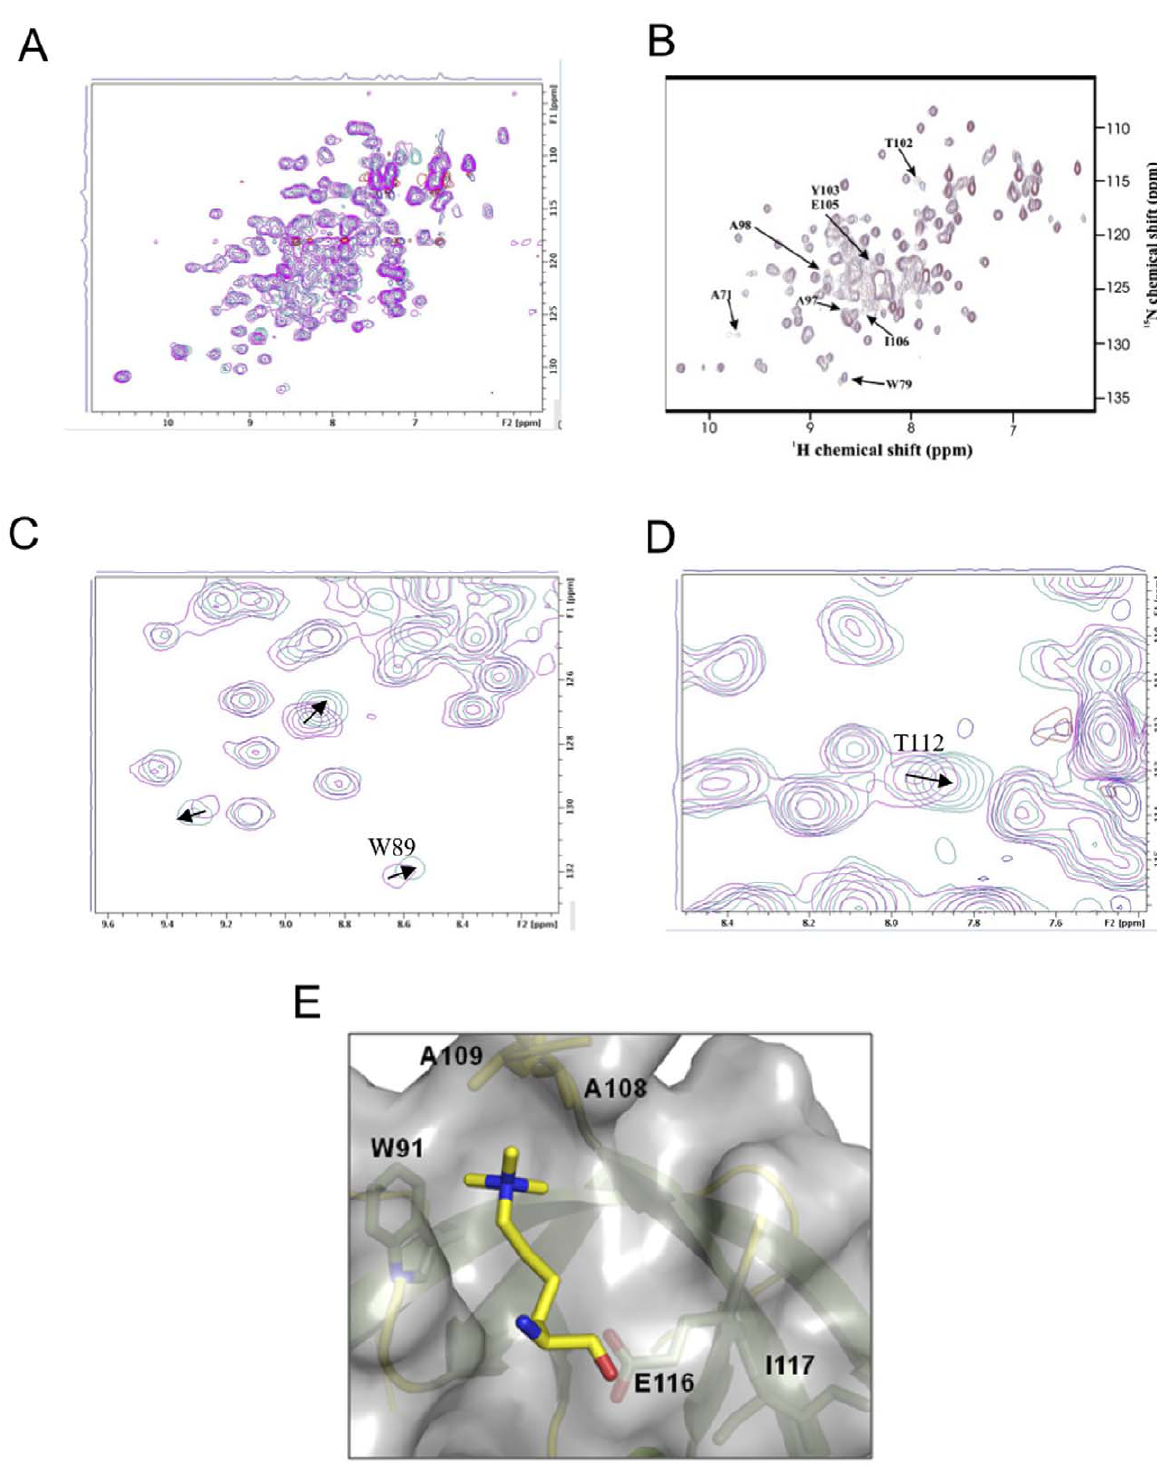
Figure 5. Recognition of trimethylated lysine by the Tud2 domain of FXR2. (A) Superposition of the HSQC spectra for the tandem Tudor domains of FXR2 in the presence (cyan) and absence (magenta) of the 1.5 molar excess H4K20me3 peptide. (B) HSQC spectra for FMRP reported in refenrence 22. (C) and (D) Specific chemical shifts corresponding to the predicted binding site for trimethylated lysine in FXR2-Tud2. (E) A model of trimethylated lysine recognition by FXR2-Tud2. Residues present in the crystal structure and that yield chemical shifts during titrations are indicated.